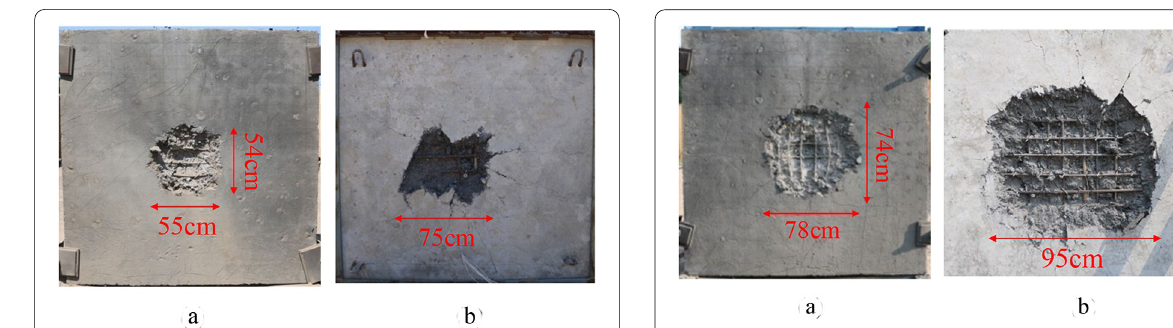
Fig. 12 FC05 slab under 6.3 kg explosion: a the frontal surface and b the back surface.